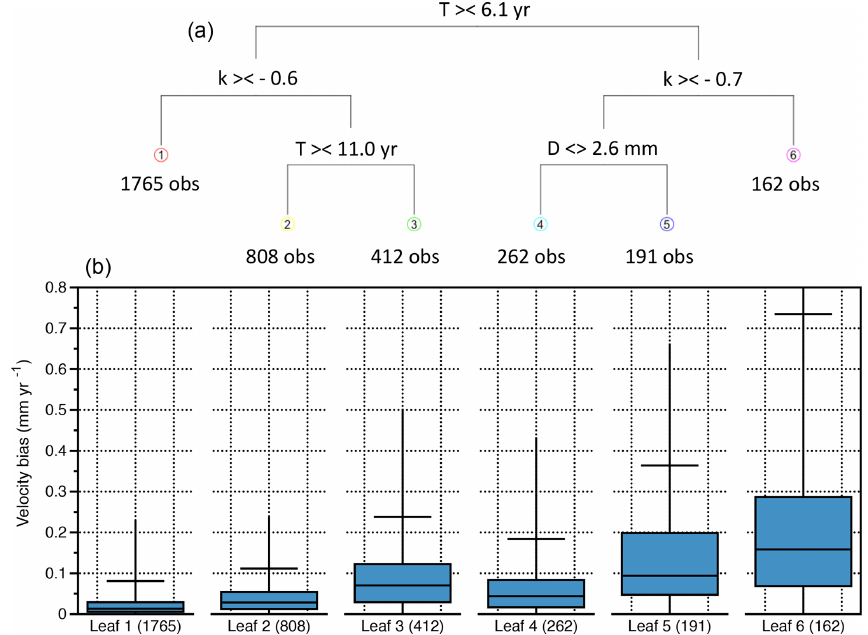
Figure 5. The regression tree classification (a) and the whisker plots of the associated leaves (b) for series including only colored noise. The horizontal top bar represents v 95